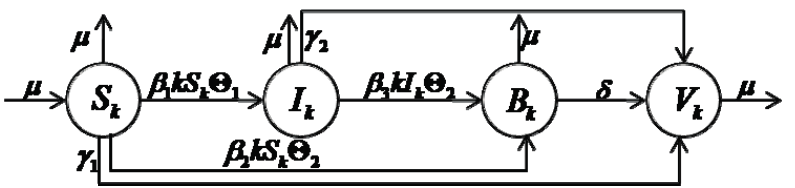
Figure 2. The transfer diagram